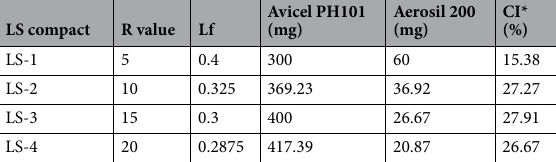
Table 3. The compositions and compressibility indexes of LS compacts. * CI Carr’s compressibility